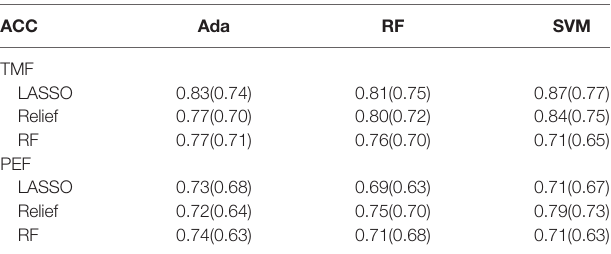
TABLE 3 | The ACC of the cross-combination methods.